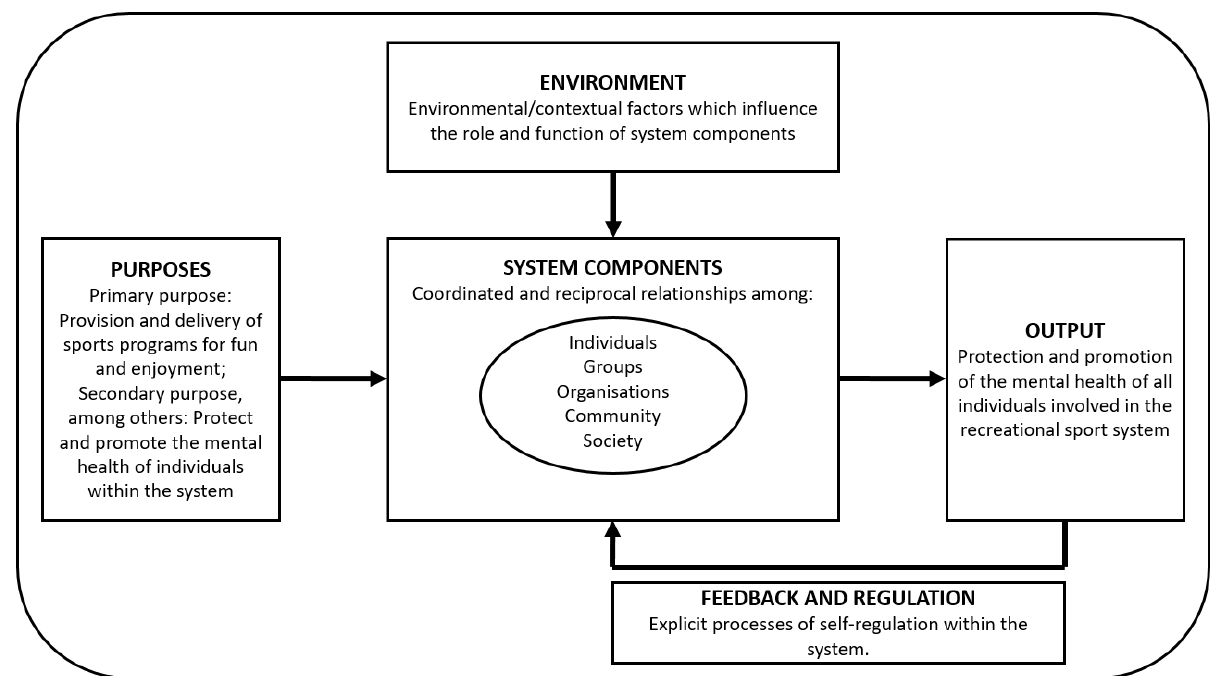
Figure 1. An overview of the theoretical postulates of the theory of mental health in recreational